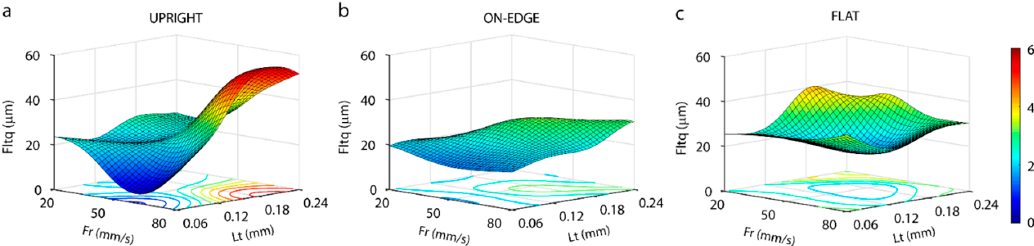
Figure 6. Response surface obtained by artificial neural networks for flatness in the three build orientations: ( a ) Upright, ( b ) on-edge and ( c ) flat.